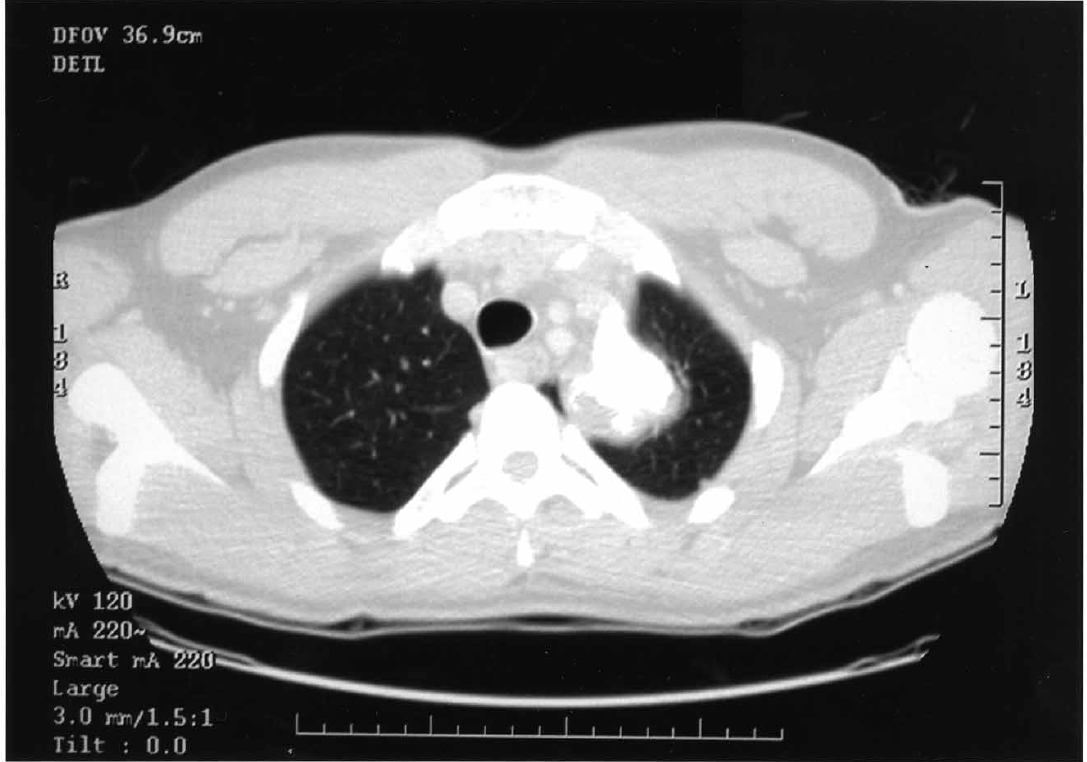
Fig. 2. Contrast-enhanced axial image of the lesion on thoracic CT scan.